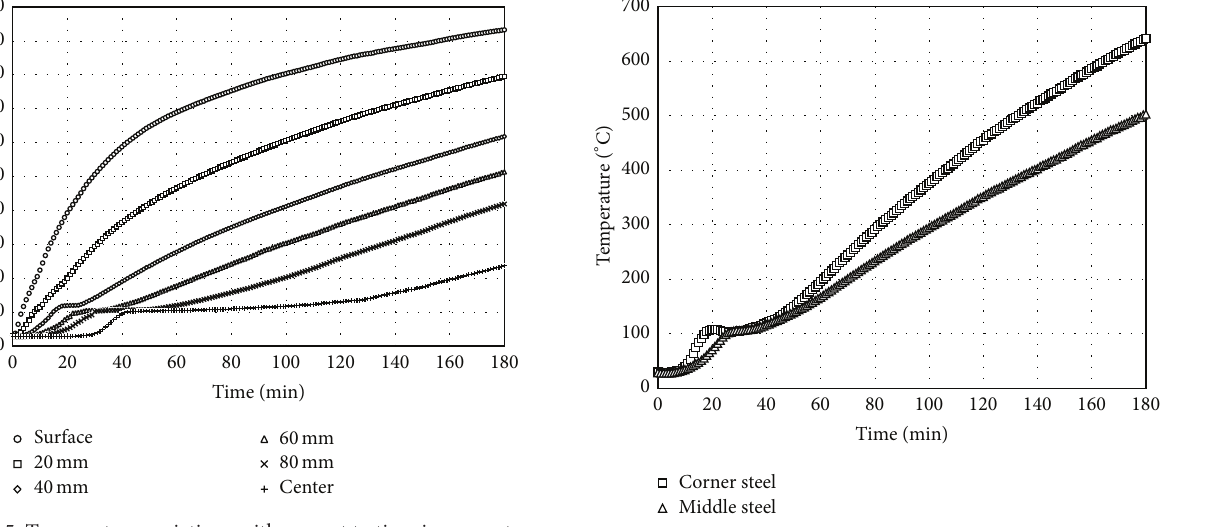
Figure 6: Temperature variations with respect to time in